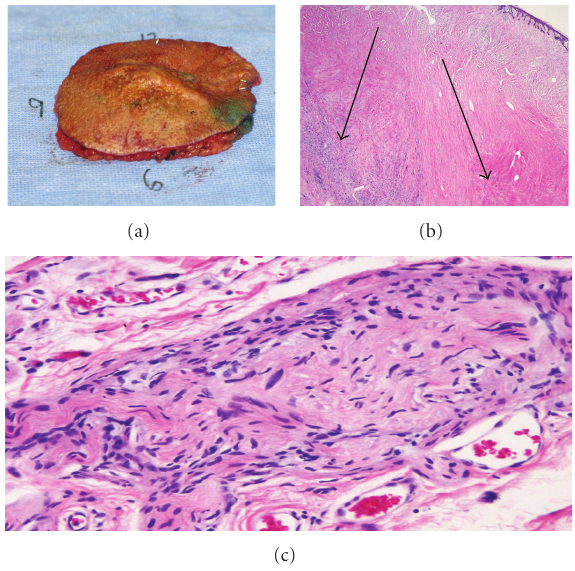
Figure 4: (a) Surgical specimen for pathology. (b) Desmoplastic melanoma (left arrow) and dermal scar (right arrow). (c) High- power view of desmoplastic melanoma.